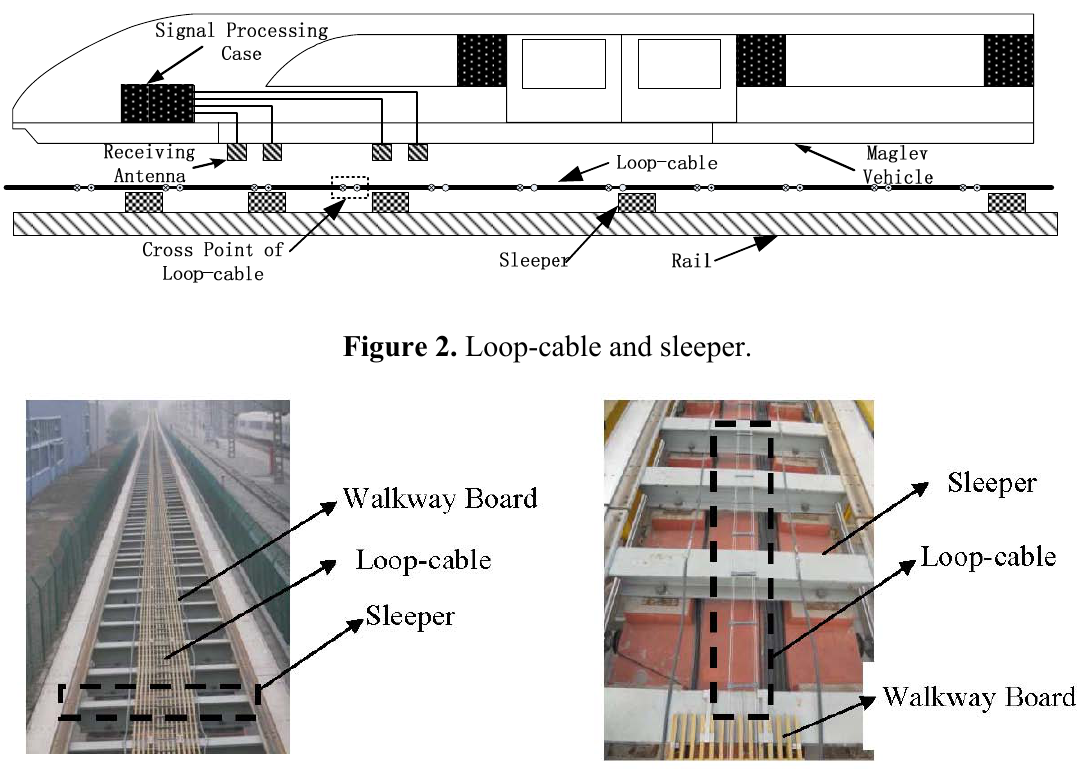
Figure 1. A sketch of the system based on loop-cable and maglev vehicle.